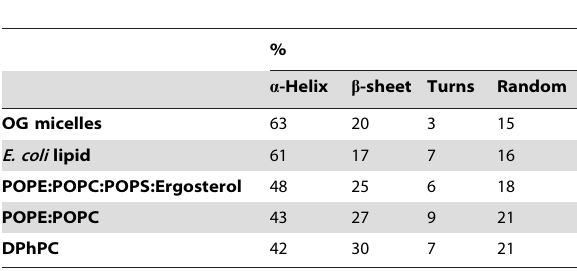
Table 1. Summary of the SoPIP2;1 secondary structure results.